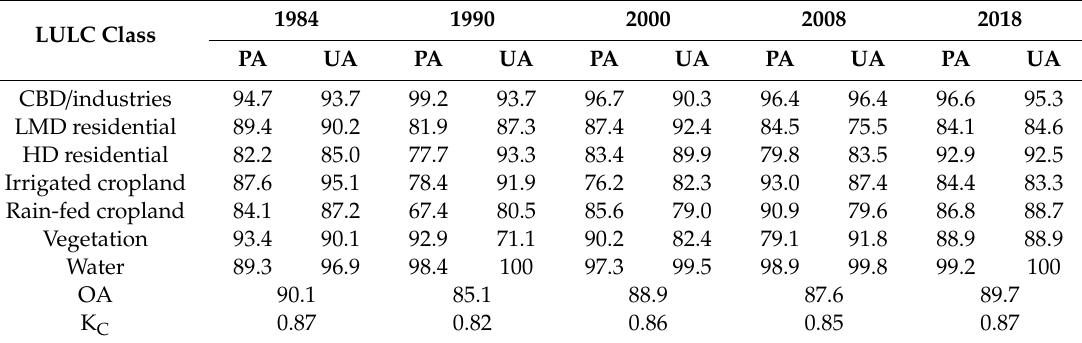
Table 4. Land use and land cover classification accuracies in percentages for the study period 1984–2018. The accuracies include Kappa coe ffi cient (Kc), overall accuracy (OA), producer’s accuracy (PA) and user’s accuracy